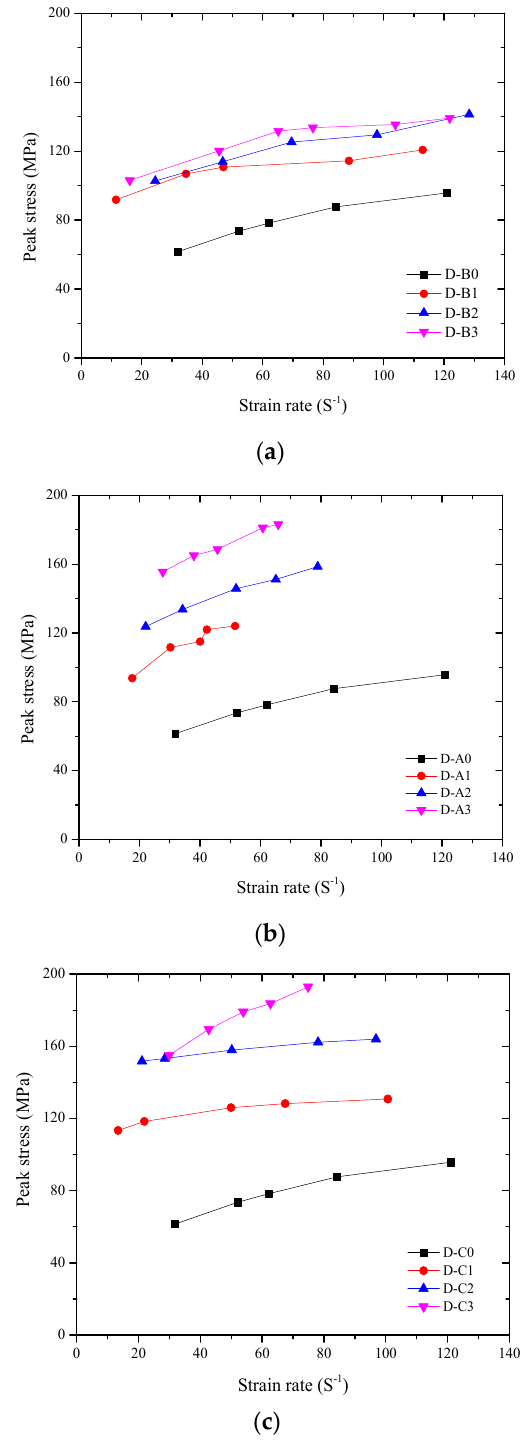
Figure 10. Relationship between the FCHC peak stress and the strain rate. ( a ) CFRP-confined specimens; ( b ) AFRP-confined specimens; and ( c ) CFRP-confined specimens.